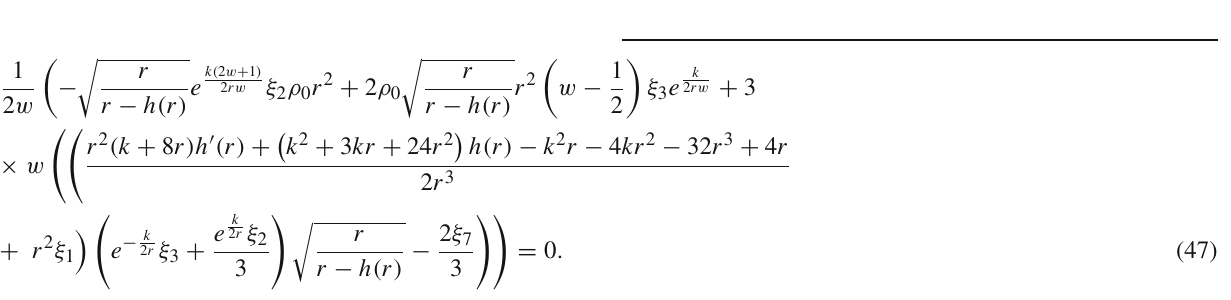
Fig. 3 Evolution of energy bounds versus r for w = −